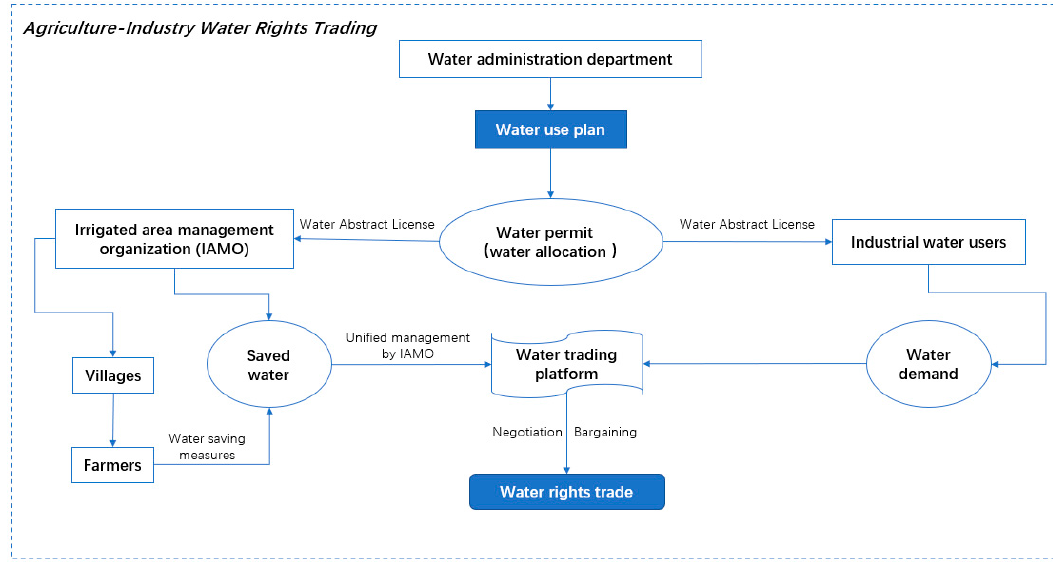
Figure 1. Mechanism of agriculture to industry water rights trading in China.